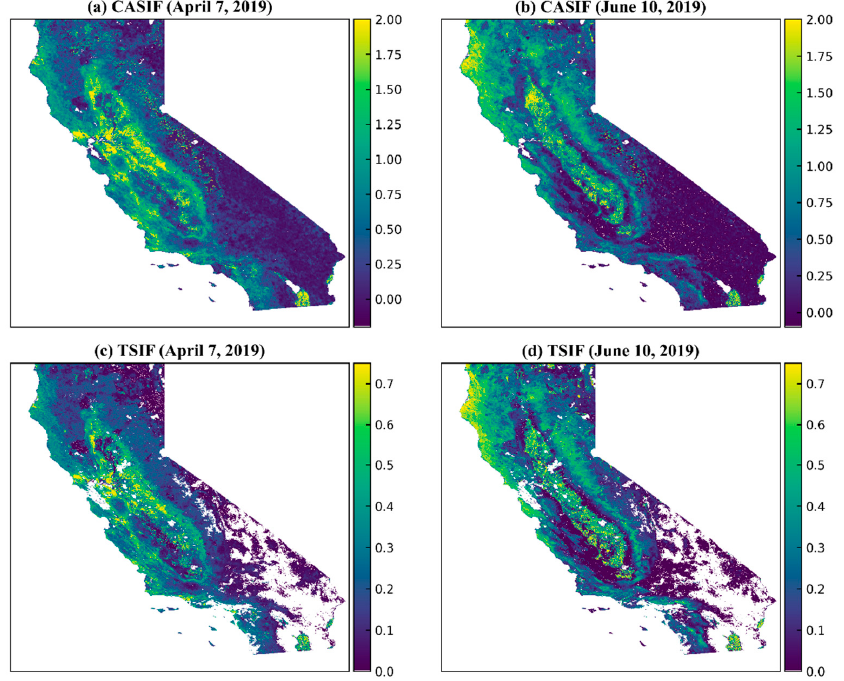
Figure 11. ( a , b ) CASIF and ( c , d ) TSIF on 7 April 2019 and 10 June 2019. CASIF are temporally aggregated to 16-day. The data gaps result from missing data in MODIS or TROPOSIF.